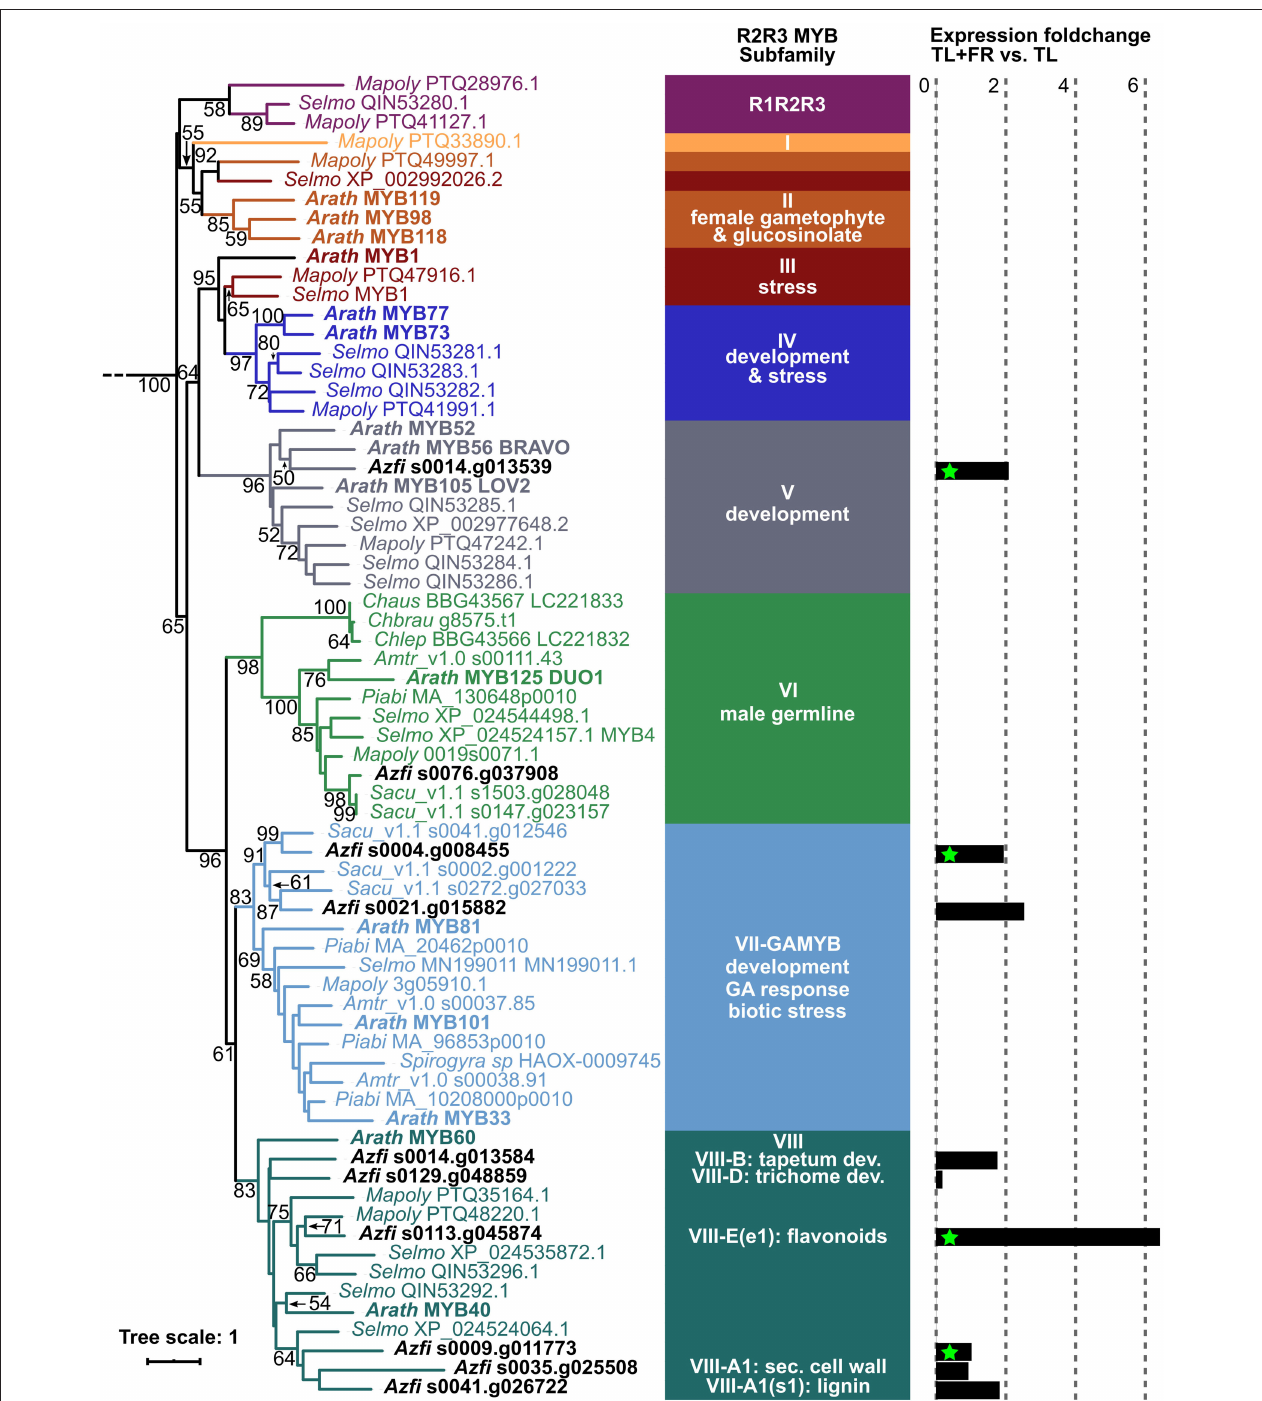
FIGURE 8 | R2R3MYB phylogenetic analyses and expression fold change in sporophytes with vs. without FR. Sequences were extracted from the genome browsers of each species, aligned with MAFFT E-INS-I (Katoh et al., 2019), and then trimmed with trimAL (gap threshold 40%; Capella-Gutiérrez et al., 2009). Phylogenetic inferences were computed with IQtree with the LG + F + R10 model as determined by the Iqtree internal model fitter (Nguyen et al., 2015); non-parametric bootstrap values are shown. Chara autralis (Chaus), Chara braunii (Chbrau), Chara leptospora (Chlep), Marchantia polymorpha (Mapoly), Selaginella moellendorfii (Selmo), A. filiculoides (Azfi), Salvinia cuculata (Sacu), Picea abies (Piabi), Amborella trichopoda (Amtr), and Arabidopsis thaliana (Arath). Sequence names are color coded after the R2R3 MYB subfamilies defined in Jiang and Rao (2020). Log two-fold change (fold change) in response to FR was calculated by DESeq2, green stars mark significant changes with P adj <